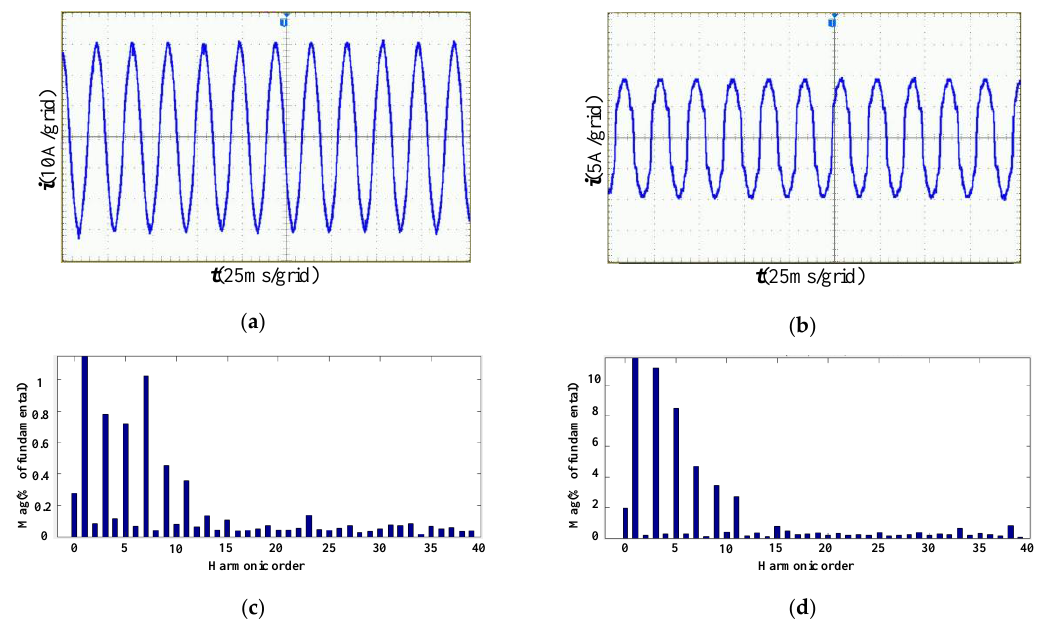
Figure 27. Grid current, HCGI output current and their THD analysis with G d . ( a ) Output current; ( b ) Grid current; ( c ) Output-current THD analysis (fundamental component = 29.249 A, THD = 2.57%); ( d ) Grid-current THD analysis (fundamental component = 9.814 A, THD = 14.17%). The grid current and output current of one HCGI without bandwidth control are presented in Figures 26a and 27a. When HCGIs work with the bandwidth control method, the grid current and HCGI output current are shown in Figures 26b and 27b. Their THD are shown in Figures 26c,d and 27c,d. The THD of HCGI output current and grid current are not affected and the frequencies of resonance points shift right.